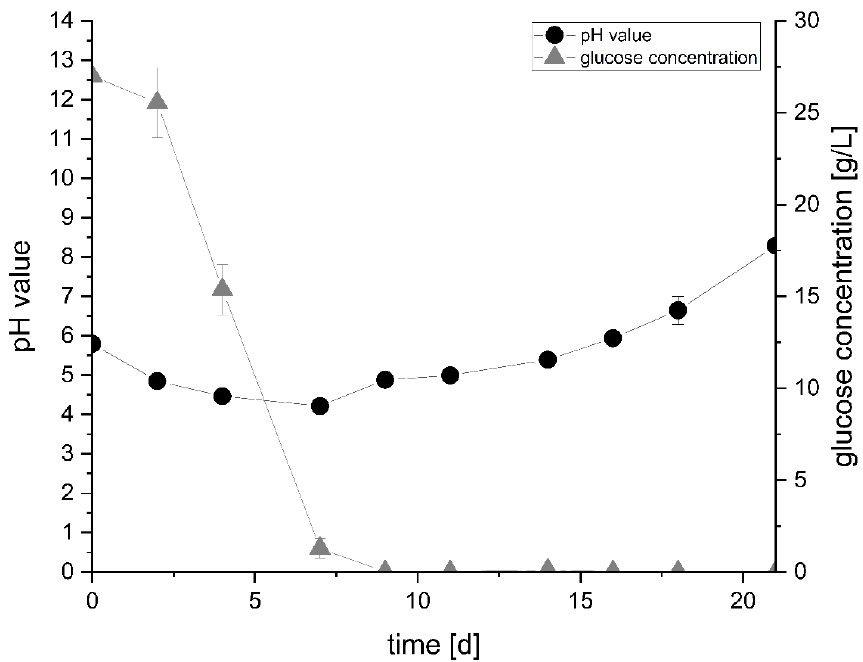
Figure 1. D-Glucose concentration and pH during the cultivation of Cerrena unicolor in SNL medium at 150 rpm and 24 °C for 21 days.